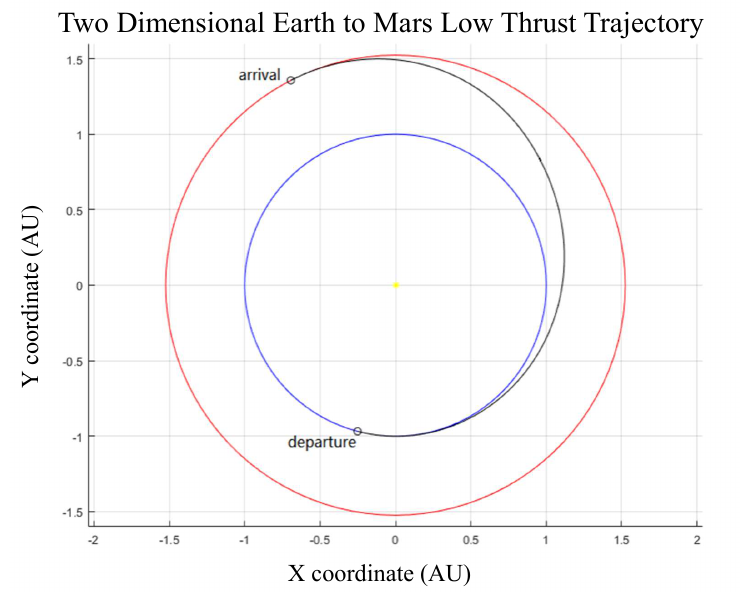
Figure 7. Heliocentric trajectories Earth to Mars (units in meters). This is one of the optimal mission profiles based on low-thrust orbital transfers using electric propulsion engines. The sun is at centre of the coordinate, the blue orbit is the Earth orbit, and the orange orbit is the Mars orbit. The black curve is the trajectory of the transfer.